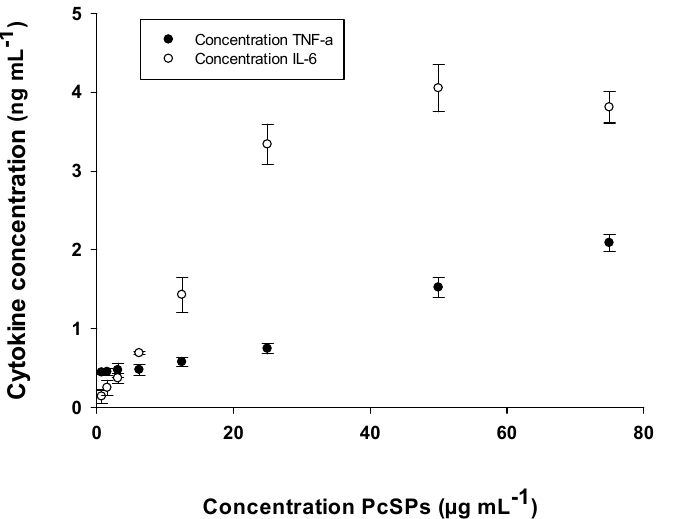
Figure 5. Production of TNF- α and IL-6 by RAW 264.7 exposed to different concentrations of PcSPs. Data points represent the average of eight samples ± SD.